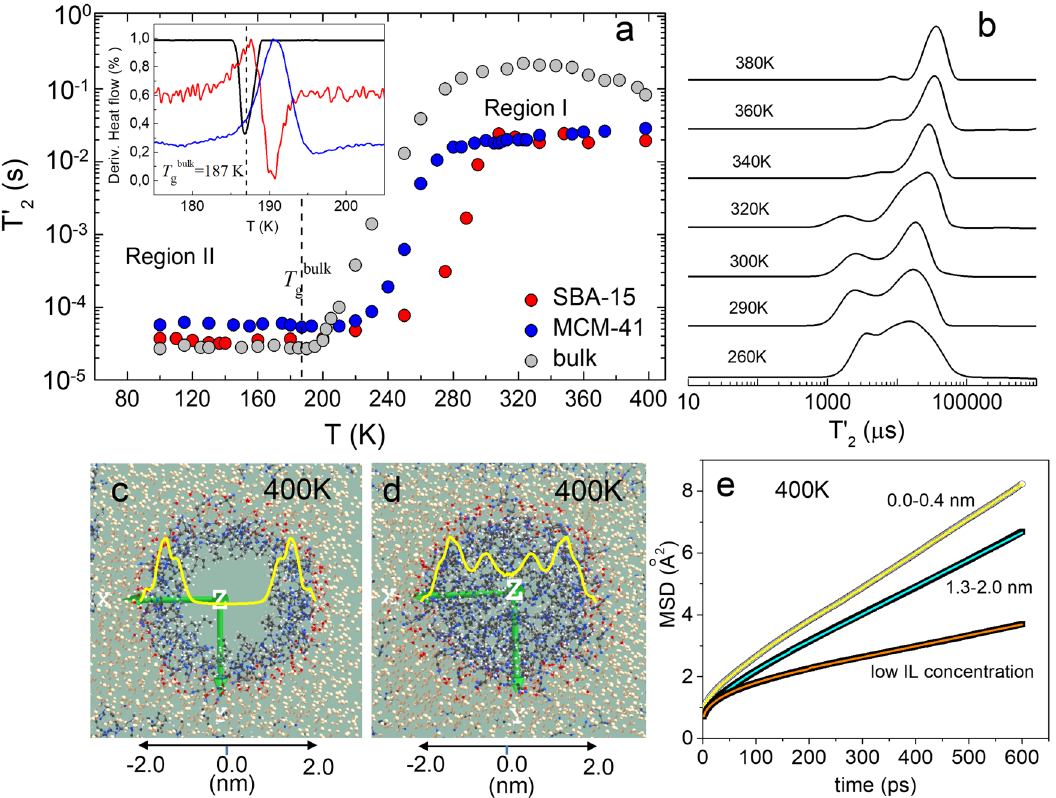
vs. T for bulk and con fi ned [BMIM] + [TCM] − in MCM-41 and Fig. 6 1 H NMR T 0 vs. T measurements combined with MD simulations. a The mean T 0 2 2 SBA-15. The inset shows the derivatives of the heat fl ow in the relevant Differential Scanning Calorimetry (DSC) experiments. b T 0 distributions of 2 [BMIM] + [TCM] − in MCM-41 at various temperatures. c , d Snapshots of a molecular dynamics simulation of RTIL at low and high concentration con fi ned in MCM-41 at 400 K. Yellow lines are the radial RTIL density. A bimodal RTIL density distribution is observed at high concentration. e The MSD in both (cid:4) (cid:5) (cid:4) τ 0 : 5 , due to the cage effect. A similar phenomenon is observed in the low RTIL concentration shells varies at initial times as z 2